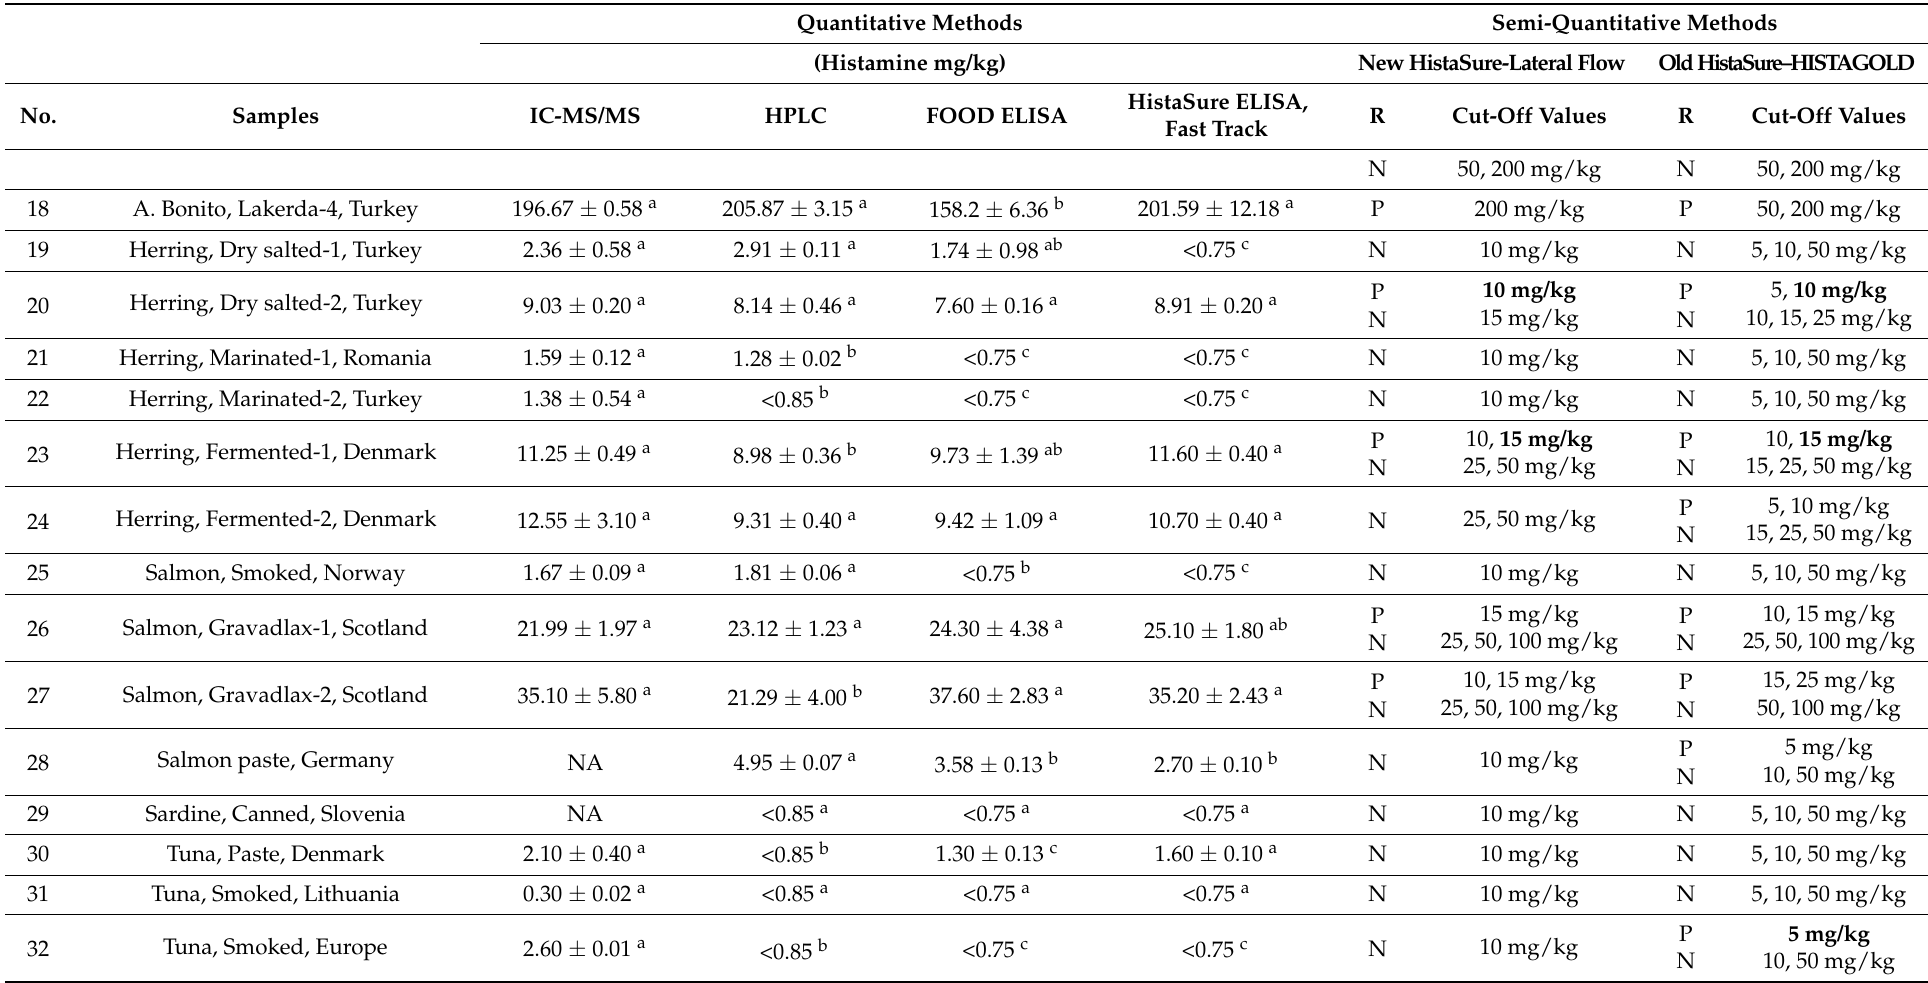
Different superscript lowercase letters (a, b, c) in the same row represent statistical differences amongst the methods ( p < 0.05). NA: Not analyzed, R: Results, P: Positive (means the value is above this cut-off level), N: Negative (means the value is below this cut-off level). Histamine LOD values for <0.85 mg/kg HPLC, <0.75 mg/kg Food ELISA and HistaSure ELISA, Gravadlax : Marinated and fermented. The bold cut-off values represent the disagreement of the method with at least one of the quantitative